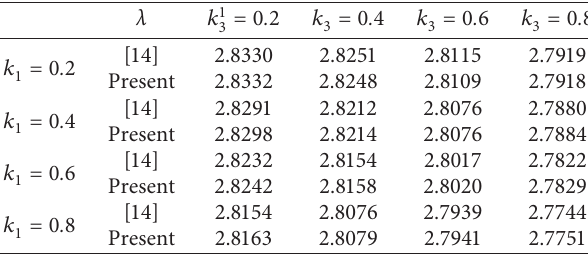
Table 1: Comparison of the dimensionless fundamental fre- quencies of bidirectional functionally graded beam with L � 20 h .